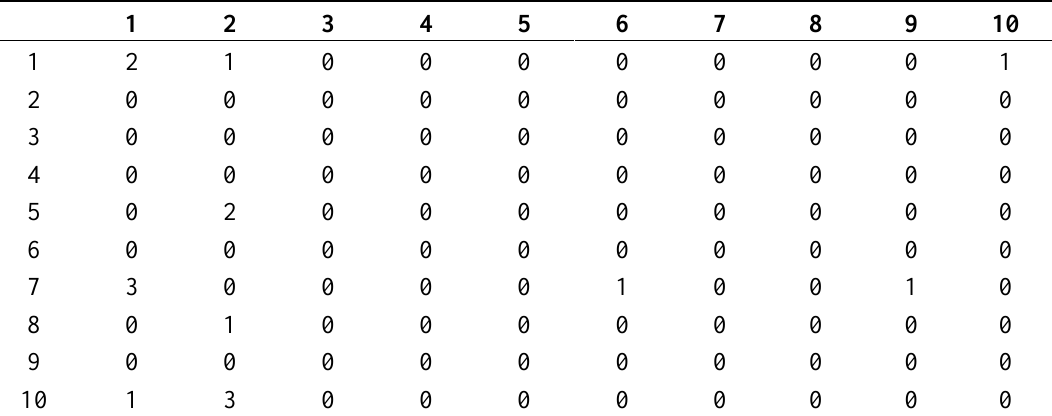
Table 2. Result of signal output in Matlab.